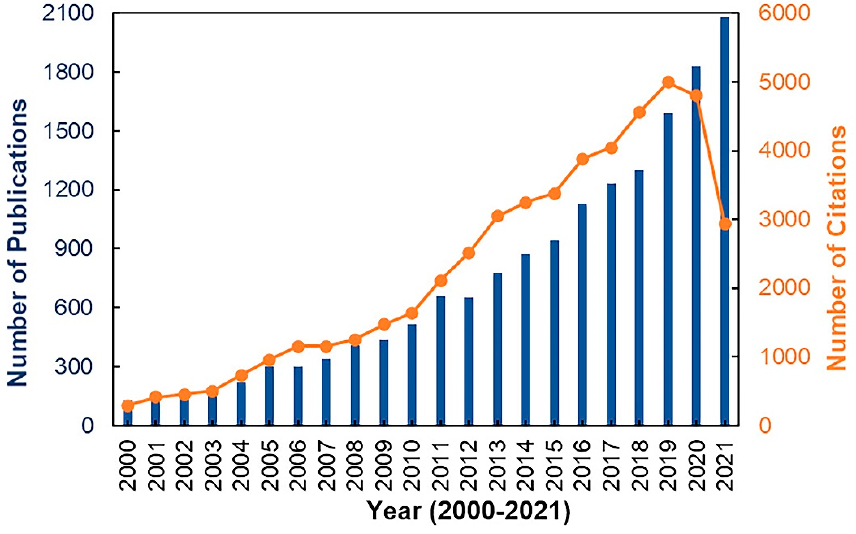
Figure 1 . Trends in the number of articles and citations identified by Web of Science (WOS) that are related to root traits from 2000 to 2021 .